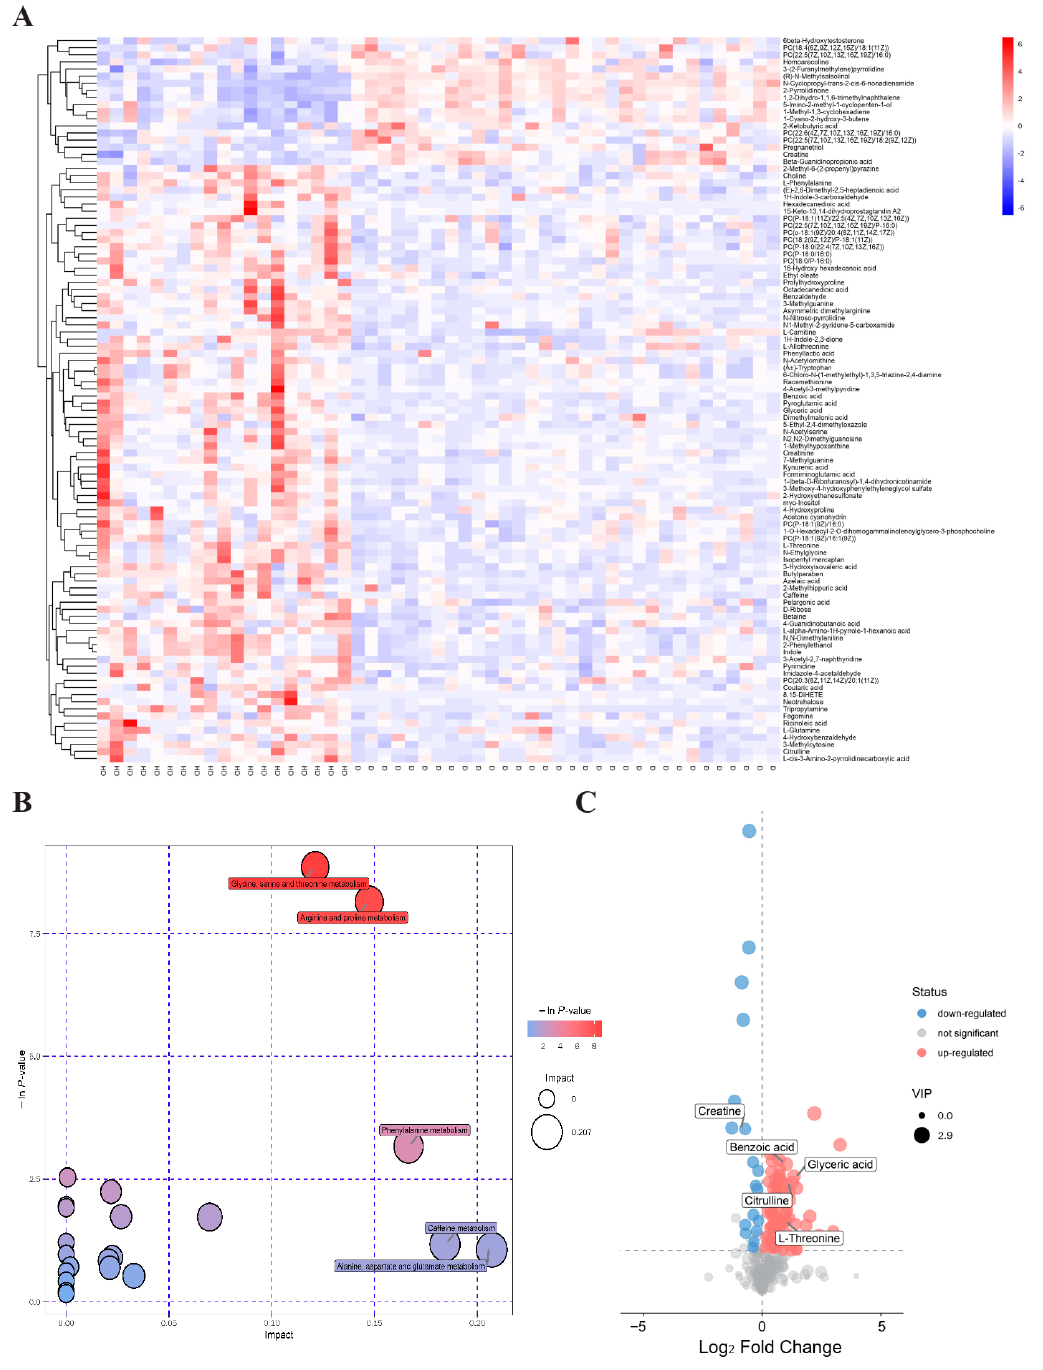
Figure 3. Dysregulated metabolites between T2DM and T2DM(+) HCC patients identified in metabolic profiling. ( A ) Hierarchical clustering showing the dysregulated metabolites between T2DM and T2DM(+) HCC patients. Each column represents a sample, and each row represents a metabolite. ( B ) Pathway enrichment analysis of dysregulated metabolites identified in the T2DM(+) HCC group versus the T2DM group. ( C ) The volcano plot depicts the difference of metabolites be- tween T2DM and T2DM(+) HCC patients. A dot represents a metabolite. D refers to T2DM patients, and HD refers to T2DM(+) HCC patients. T2DM, type 2 diabetes mellitus; HCC, hepatocellular